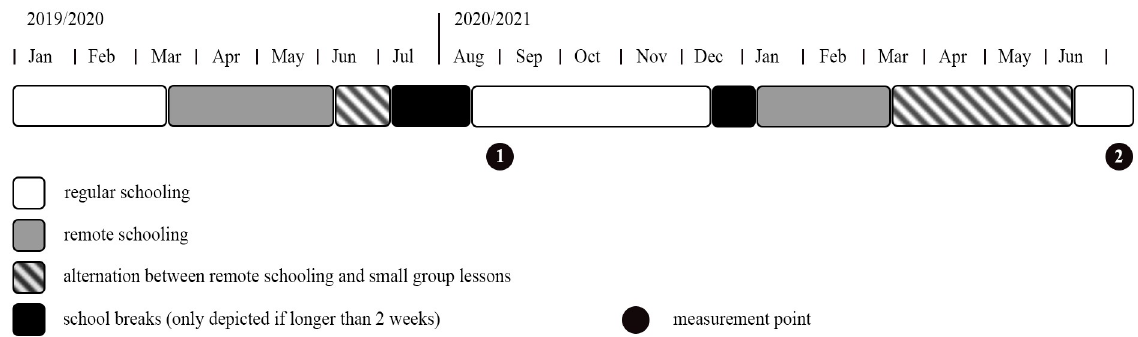
Fig 1. Timeline of schooling for students in Grades 7–10 in Rhineland-Palatine,